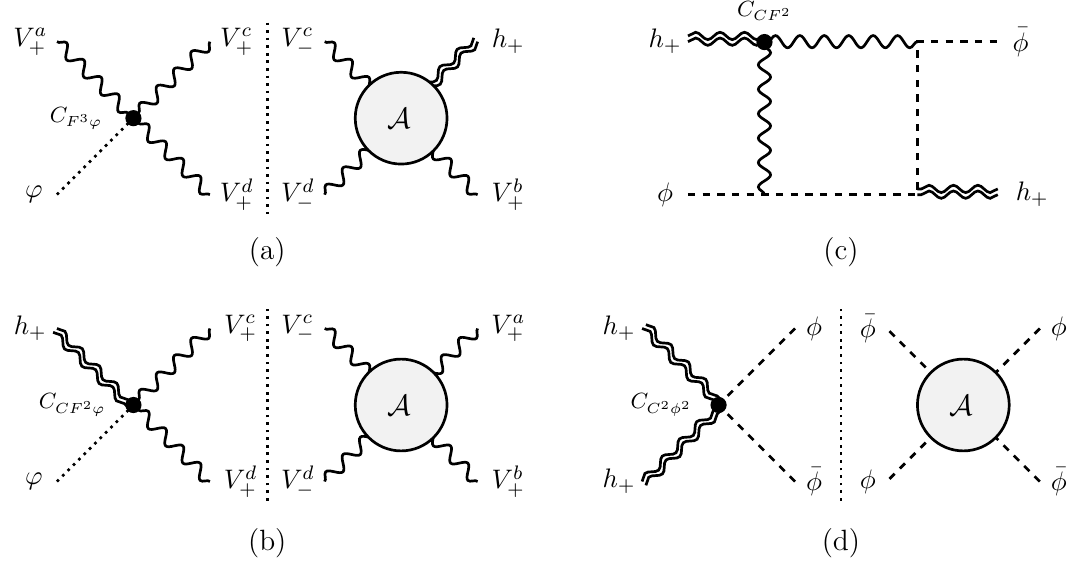
Figure 8 . Diagrams relevant for mixings among operators containing at least one graviton at O (Λ − 2 )